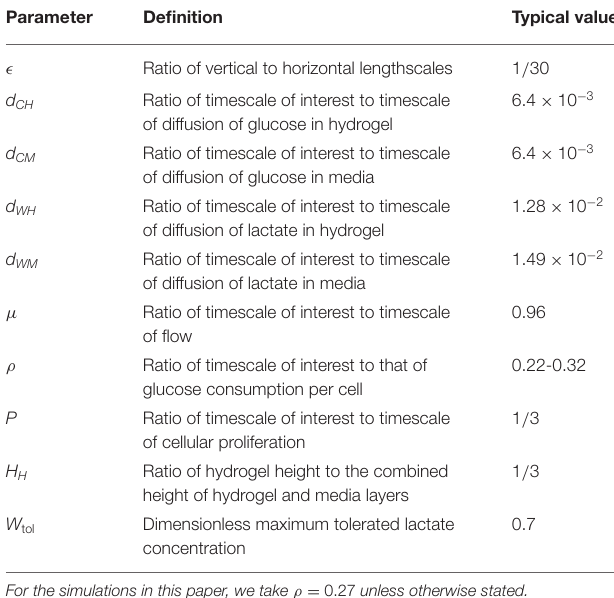
TABLE 3 | Definitions of non-dimensionalised model parameters with their typical values.